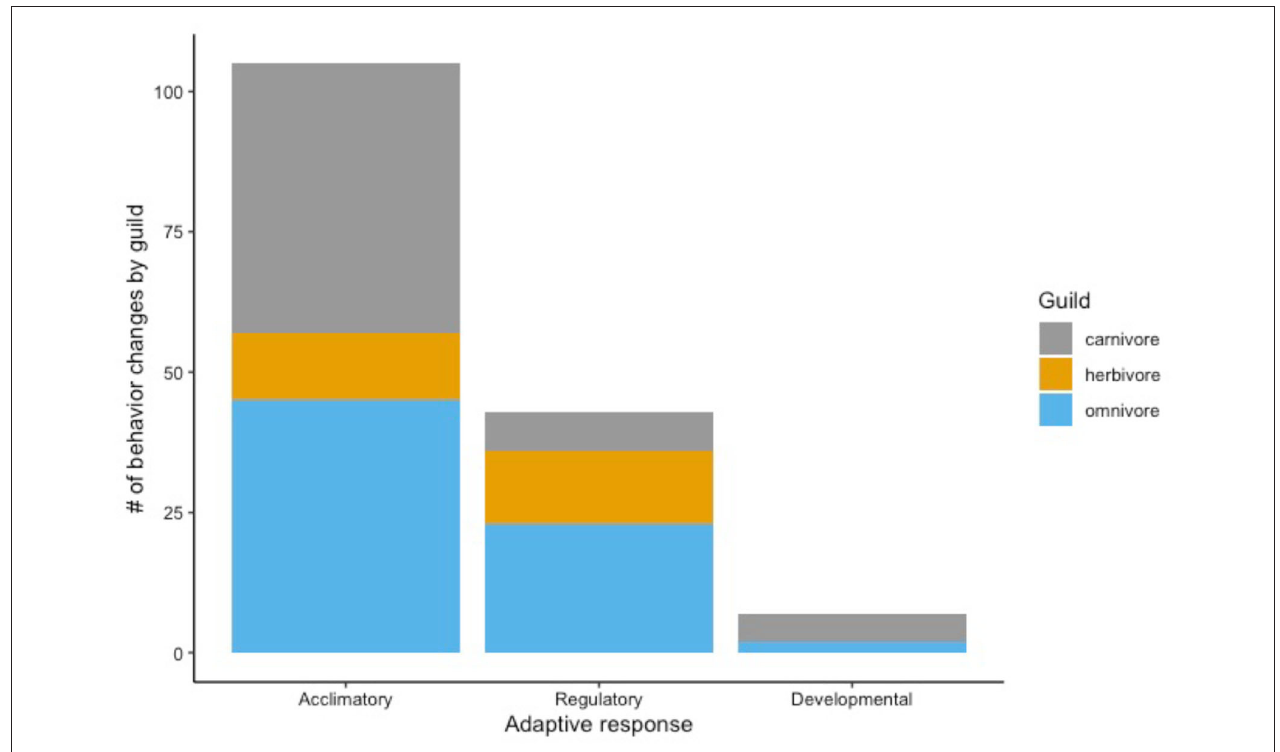
FIGURE 5 | The number of behavior changes by diet guild in urban mammals from 1987 to 2020 categorized by adaptive